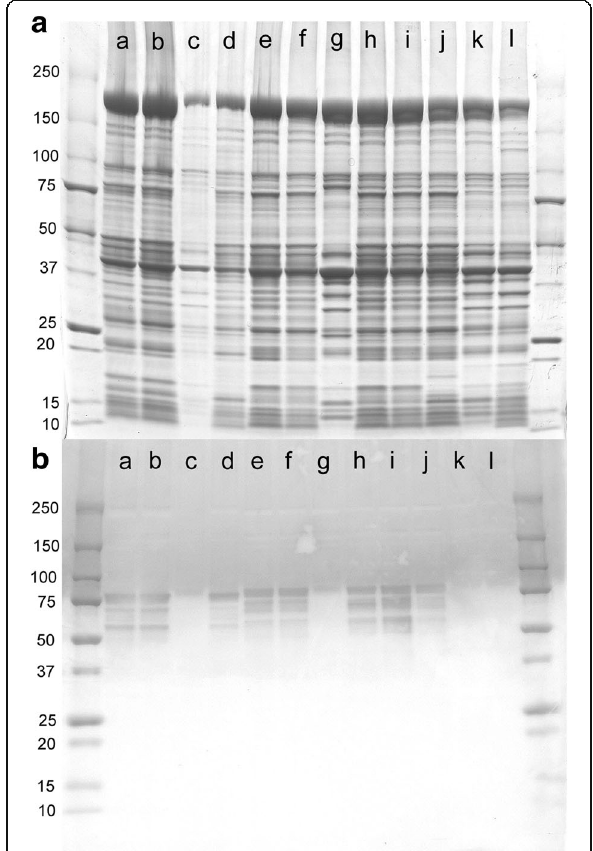
Fig. 5 SDS gel electrophoretic and immunoblot patterns of the muscle fibers from Terpnosia vacua and Meimuna oparifera. A Coomassie brilliant blue-stained SDS gel electrophoretic pattern; B Western blot pattern obtained by using an antibody against flight muscle-specific troponin-I (troponin-H). Lanes a-d, Terpnosia vacua ; lanes e – l, Meimuna oparifera . a and e, DLM; b and f, DVM; c and g, 3Ax; d and j, tymbal; h, basalar; i, subalar; k, tensor; l, leg (foreleg femur). The patterns were corrected for the deformation of the gels (expansion and fanning out) (applies also to Additional file 3: